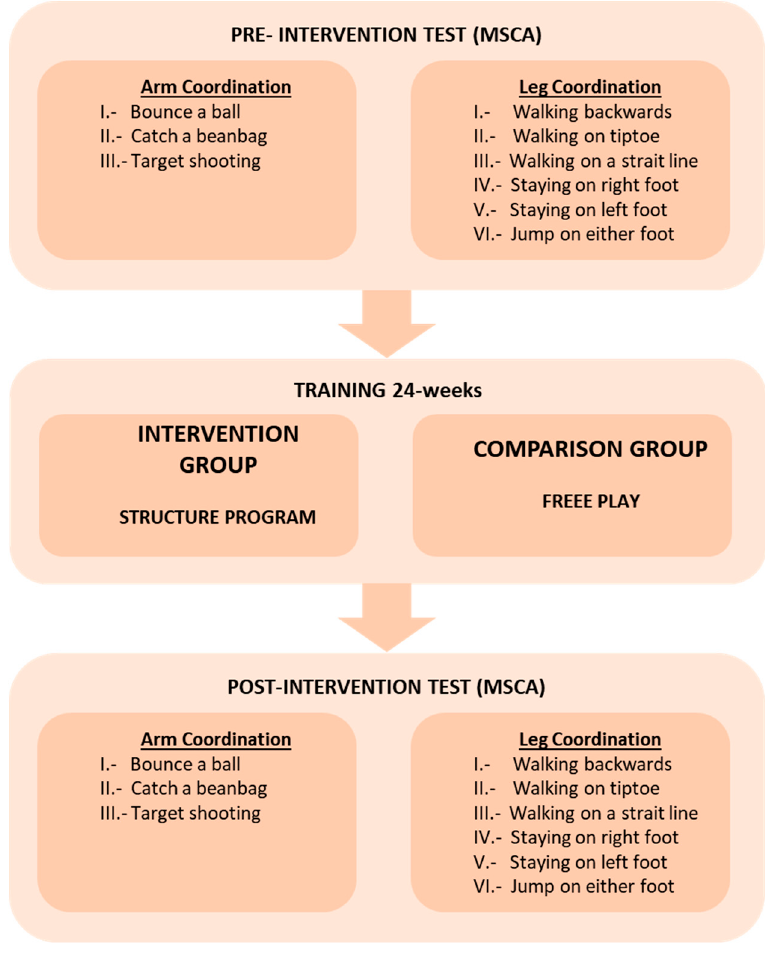
Figure 1 . Procedure model. Figure 1. Procedure